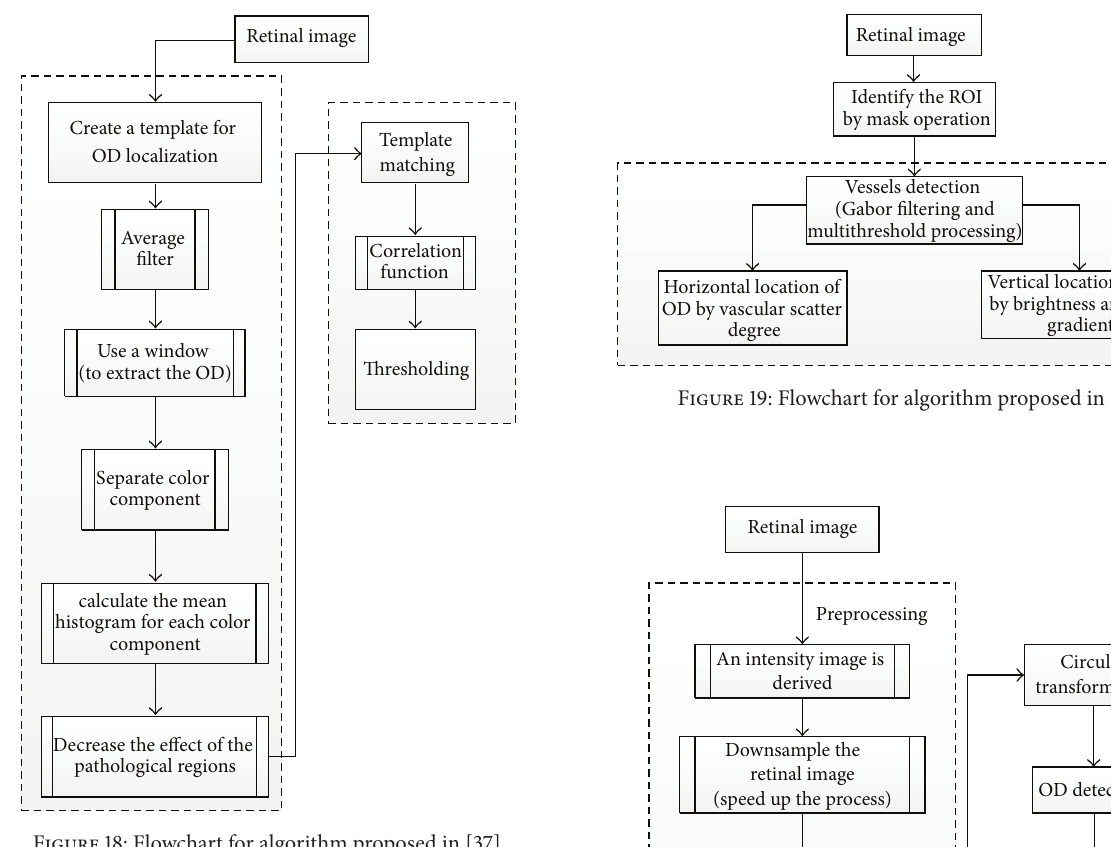
Figure 18: Flowchart for algorithm proposed in [37].